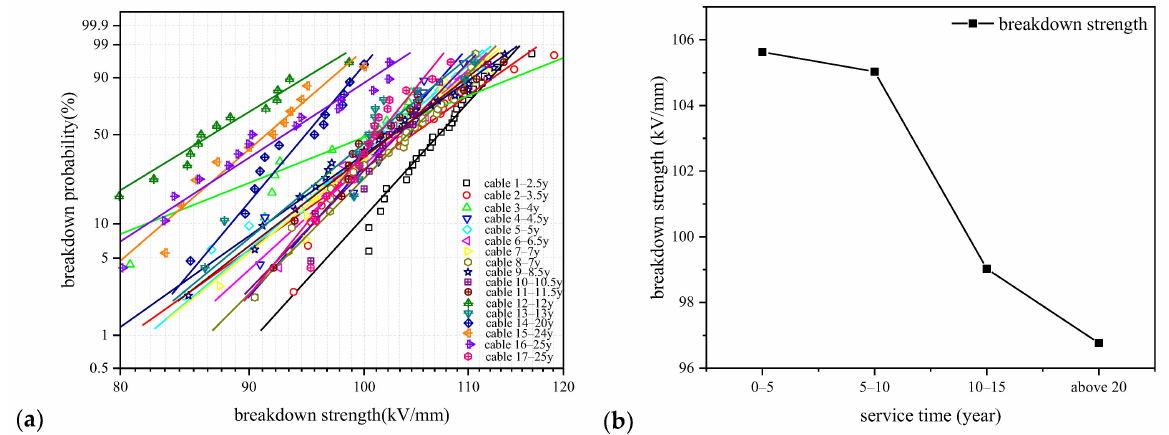
Figure 10. AC breakdown strength of XLPE films. ( a ) Weibull distribution of the breakdown strength of XLPE films of each cable; ( b ) breakdown strengths of XLPE films of each